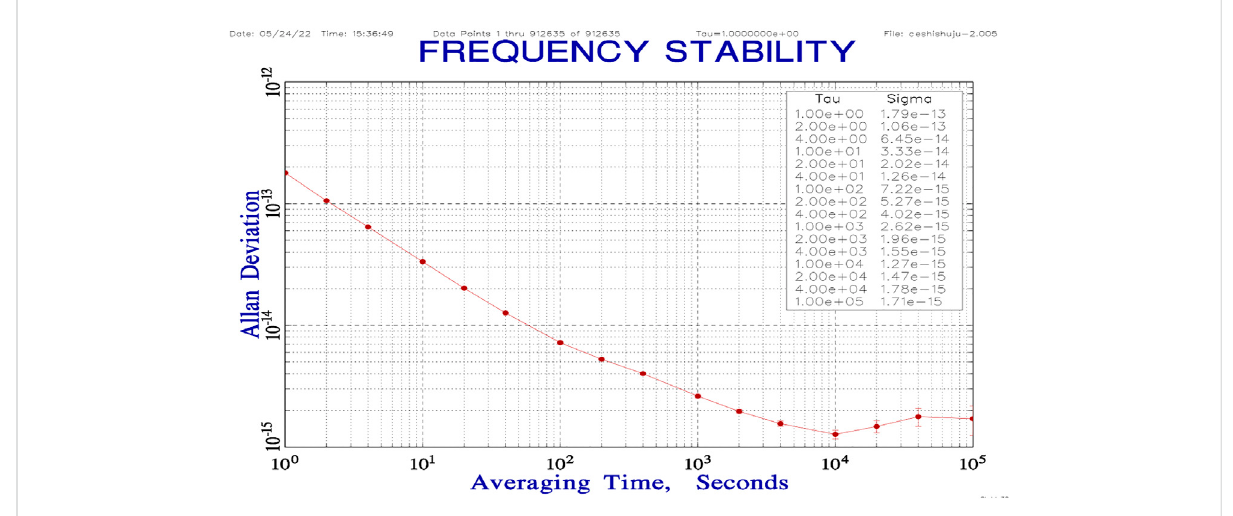
Figure 9. The ions decay from the 6 2 P 1/2 state to the two hyper fi ne states (6 2 S 1/2 , F = 0 and 6 2 S 1/2 , F = 1). The 194 nm continues illumination populates the 199 Hg + ions to the lower hyper fi ne state (6 2 S 1/2 , F = 0). Applying resonance radiation at the hyper fi ne frequency of 40.5 GHz restores the population of the upper state (6 2 S 1/2 , F = 1).